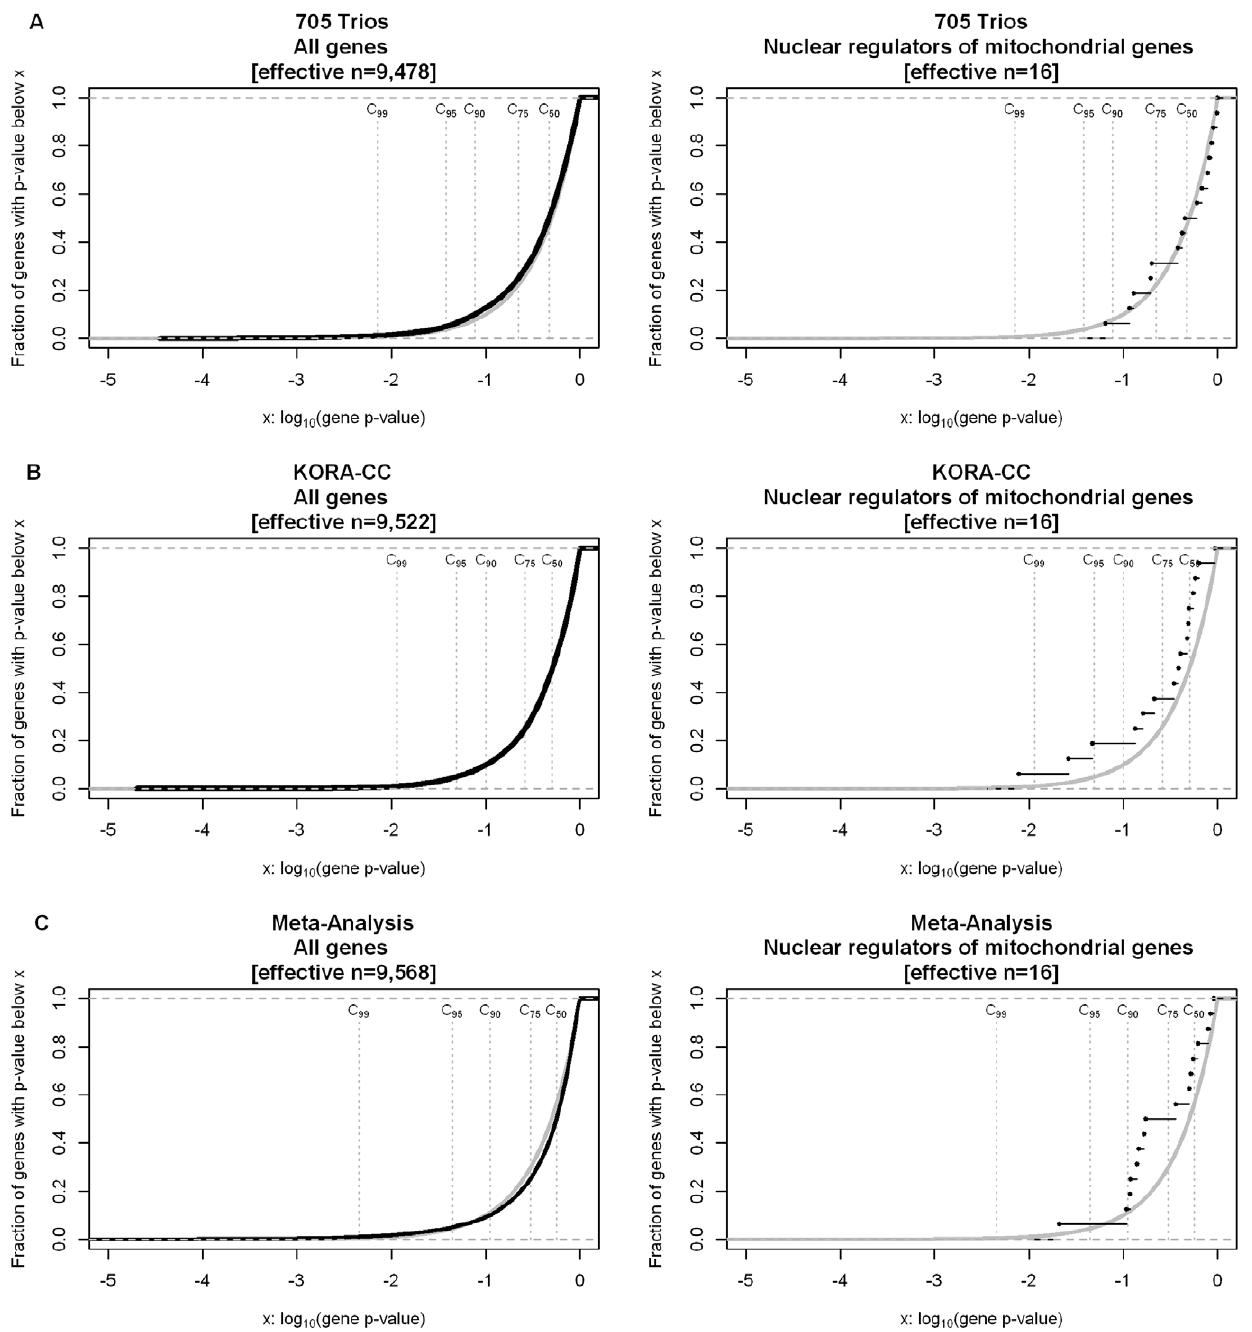
Figure 2. Empirical cumulative distribution functions (ECDF) of P g in all autosomal genes and gene set 1. For independent confirmation of the initial finding, GSEA was performed in 705 obesity trios ( A ) and in 463 obese cases and 483 normal weight or lean controls of the KORA-CC sample ( B ). In addition, a meta-analysis of all three study samples (from Discovery and Confirmation) was performed ( C ). In each panel the grey line represents the ECDF of the uniform distribution (null hypotheses of no association) and the black line represents the ECDF of the respective gene set. P g , gene-wise corrected p-value.